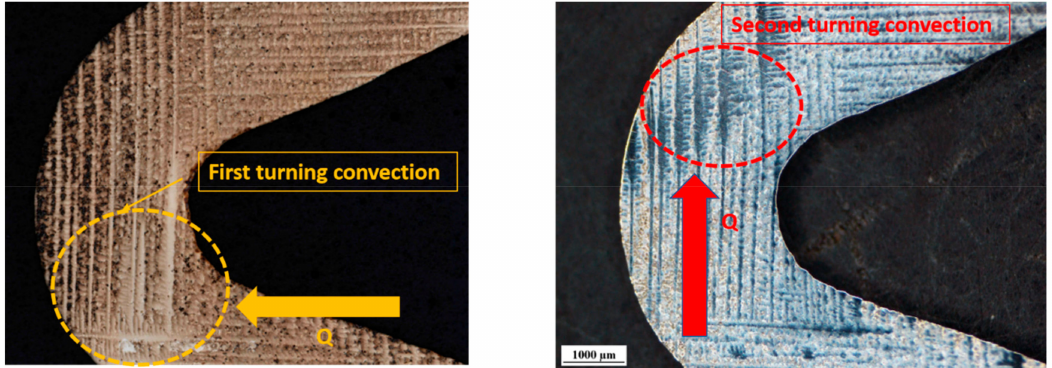
Figure 10. The dendrite turning convection relationship with the heat